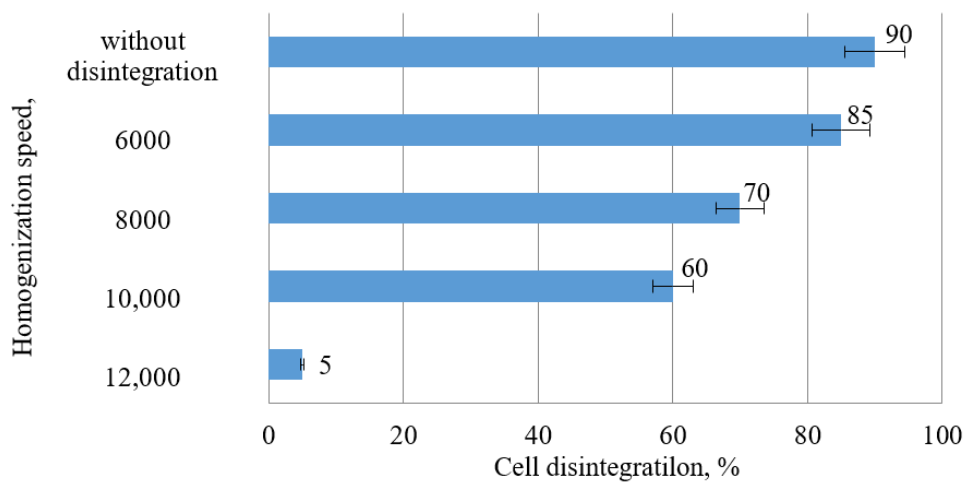
Figure 6. Influence of the rate of homogenization on the quantity of cell disintegration.